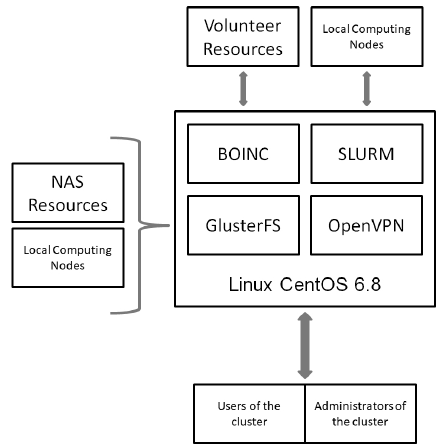
Figure 1. Architecture of the BOINC project. The platform is centralized and includes server and user-side parts. User-side part consists of a client and a graphical program – BOINC Manager. The manager brings the GUI for controlling of one or many BOINC clients. Proper details of BOINC project can be found in [3], improvements in [4]. The most recent changes and documentation can be obtained from the Github repository and the o ffi cial website.